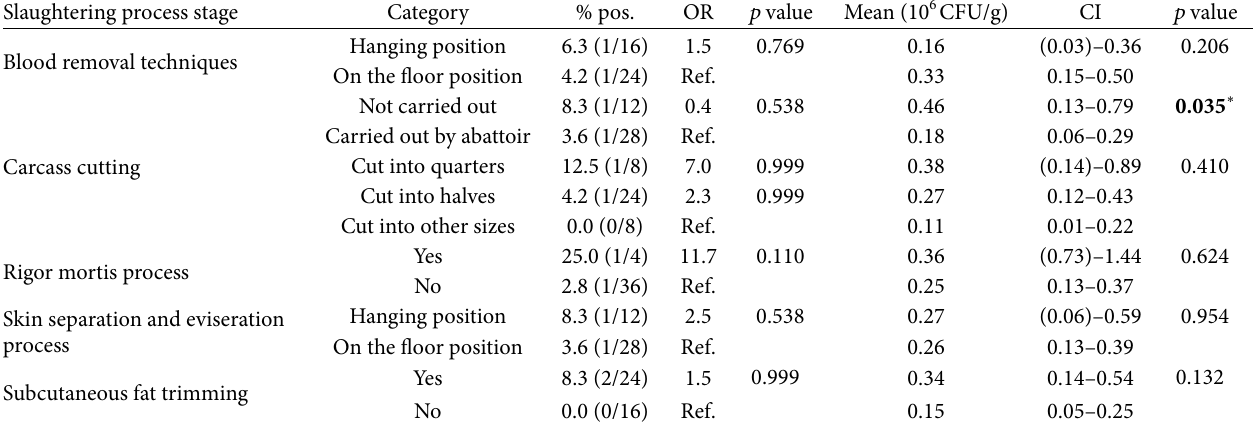
Table 2: Total plate count.